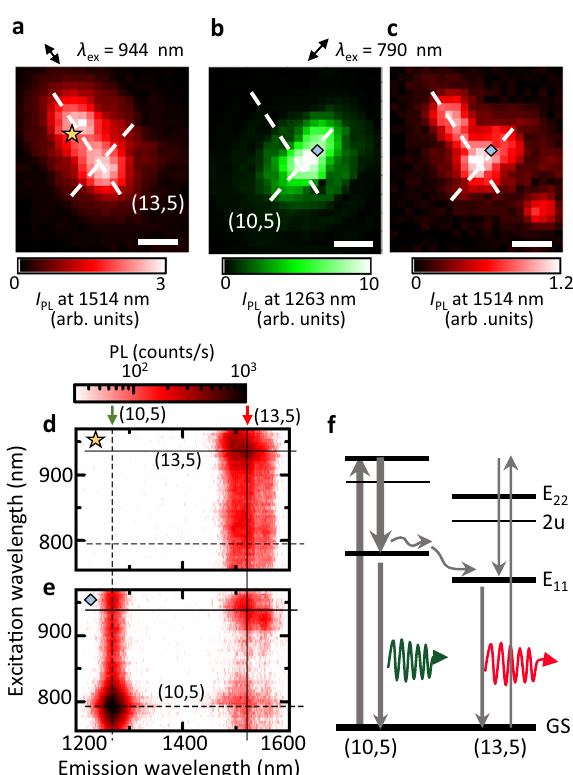
Fig. 5 Crossed CNTs formed through multiple transfer processes. a Confocal PL image of a transferred (13,5) CNT, which has an emission peak at 1514 nm, with the excitation at its E 22 resonance (944 nm) and the laser polarization parallel to the tube axis. b PL image of a (10,5) tube at emission wavelength λ em of 1263 nm, taken with excitation near its E 22 resonance (790 nm) and the polarization parallel to its axis. c PL image at λ em = 1514 nm, which is simultaneously obtained with b . Scale bars are 1 μ m. d , e PLE maps measured at the yellow star and the blue diamonds in a – c . f Schematic of energy diagram for the (10,5) – (13,5) CNT heterostructure, showing emission at 1263 and 1514 nm with excitation wavelength λ ex = 790 nm. P = 100 μ W for all the panels. The substrate is covered with a PMMA fi lm before the CNT transfer, and measurements are performed without removing the anthracene crystal used for transferring the (13,5)